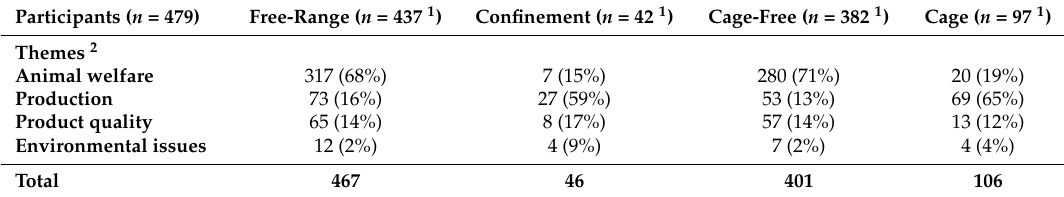
Table 2. Emerging themes in response to the question, “Please justify your preference on the livestock production system chosen in the previous answer.” Questionnaire was applied between September 2014 and June 2015, n = 479 Brazilian